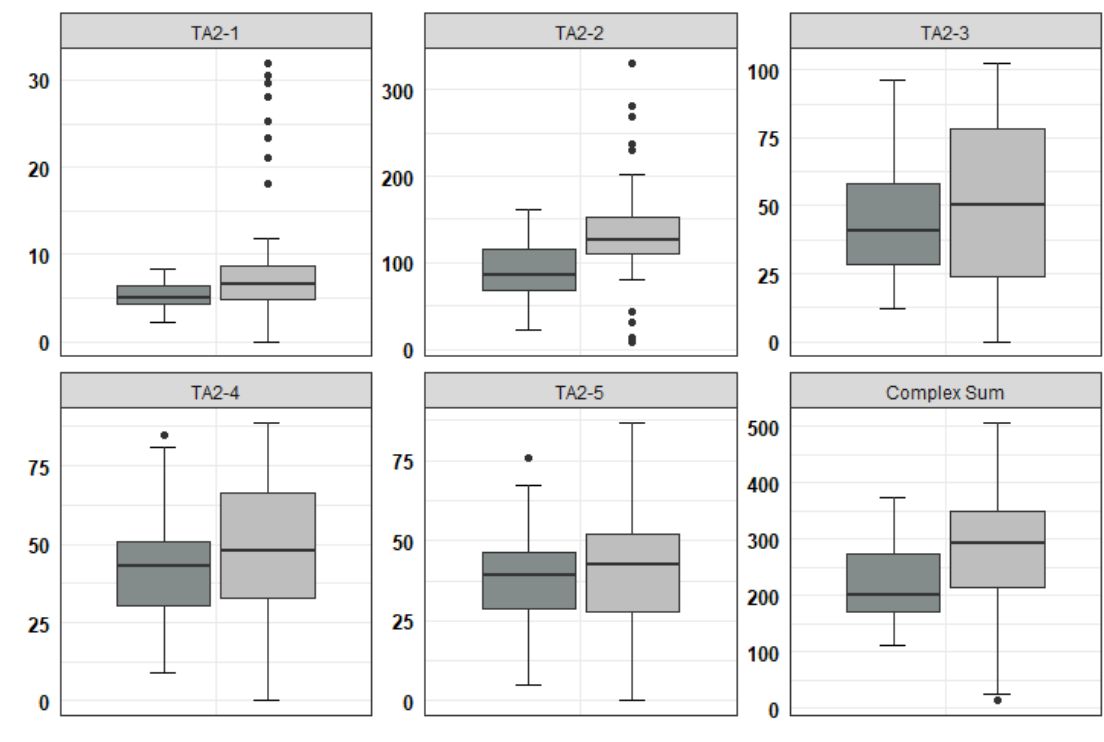
Figure 4. Boxplot distribution of teicoplanin production from fermentation of hyphae-derived clones (Origin: Hyphae; N = 49) and protoplast-derived clones (Origin: Protoplast; N = 49). Dispersion of productivity both in overall production and in single complex factor production was increased in protoplast-derived clones.